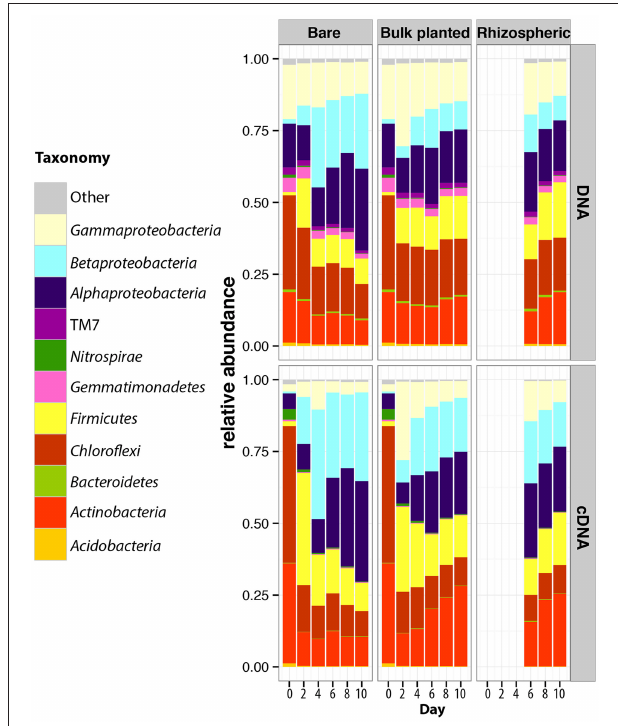
FIGURE 4 | Dynamics of the taxonomic composition of resident and active bacterial communities in bare, bulk planted and rhizospheric soil. Values are mean of three independent microcosms. For comparison, data for day 0 in bare soil were also plotted for bulk planted